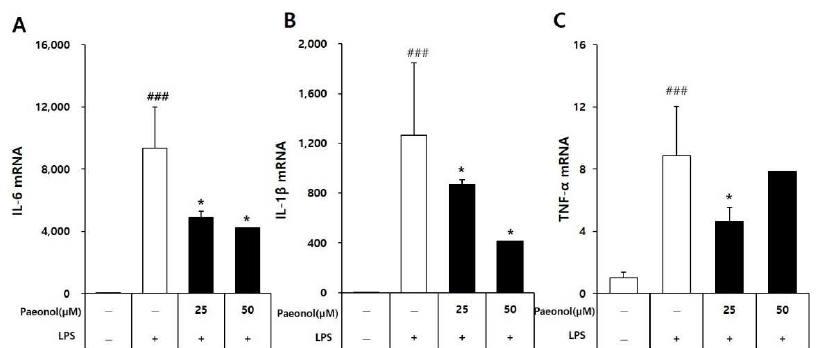
Figure 6. Paeonol decreases the mRNA expression of pro-inflammatory cytokines in LPS-activated RAW264.7 cells. The cells were treated with paeonol for 2 h, followed by LPS (100 ng/mL) stimula- tion for 4 h, respectively. After treatment, RNA was isolated from all groups and converted into